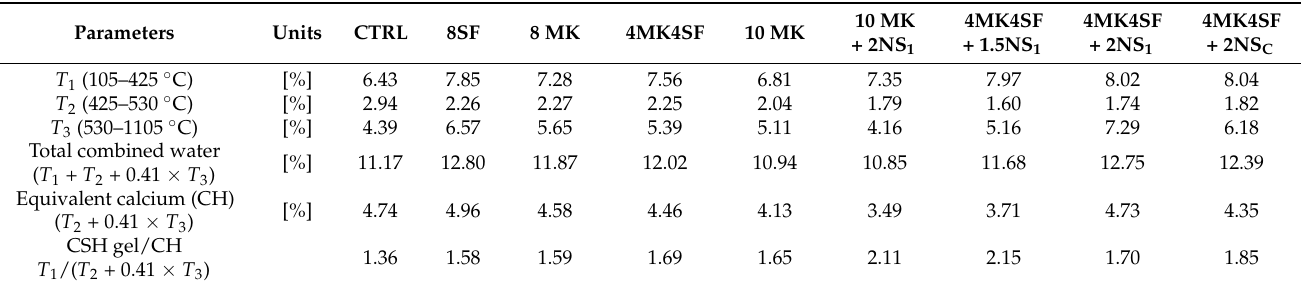
Table 6. Percentage of water loss according to temperature ranges at 28 days.